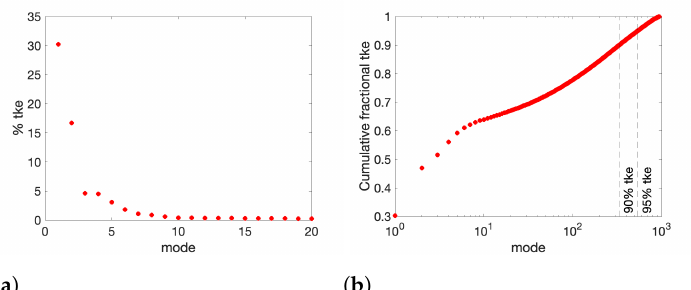
Figure 11. Super-upper branch U ∗ = 5.5. ( a ) Energy of the first 20 POD modes expressed as a percentage of the turbulent kinetic energy ( tke ) and ( b ) cumulative energy.